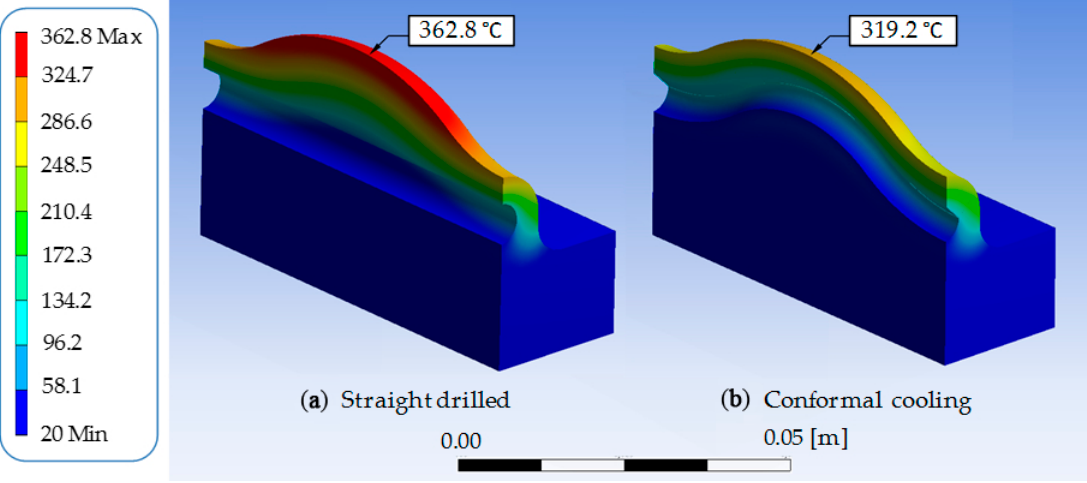
Figure 18. Thermal simulation results of conventional drilled (a) vs. conformal (b) cooling.